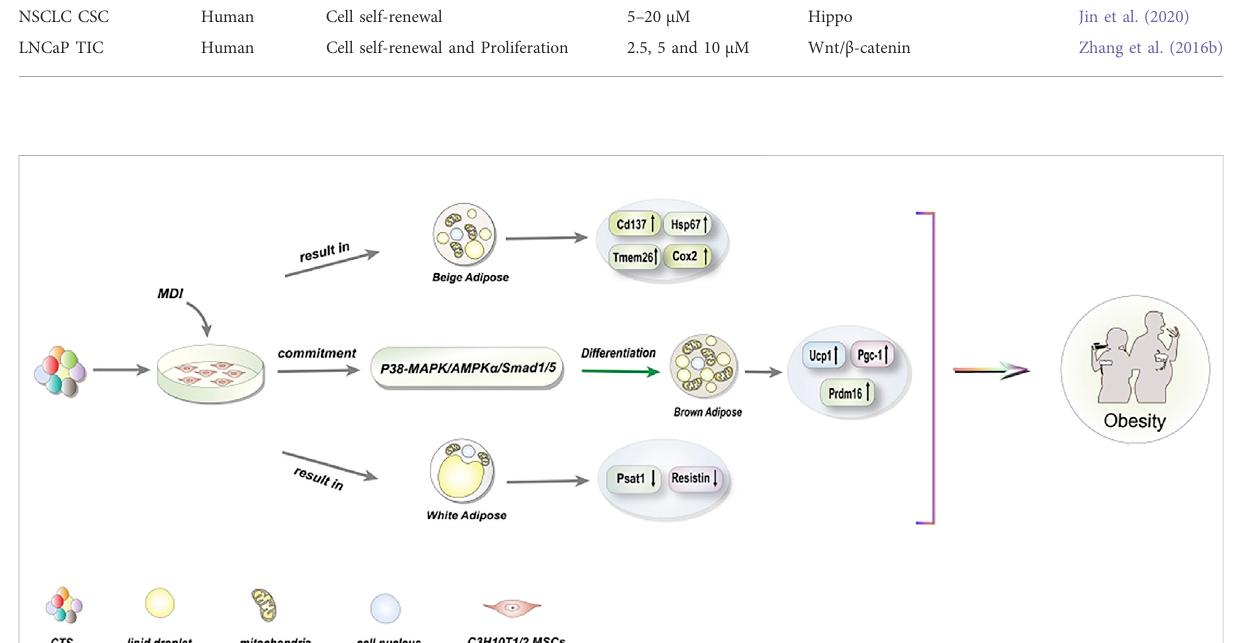
FIGURE 1 Schematic diagrams of the effects of CTS on differentiation of C3H10T1/2 MSCs for the treatment of obesity.